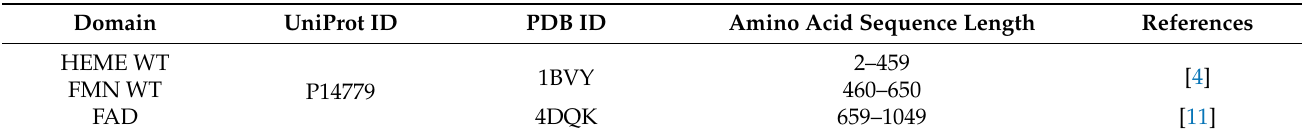
Table 1. Information about the structures of the studied protein